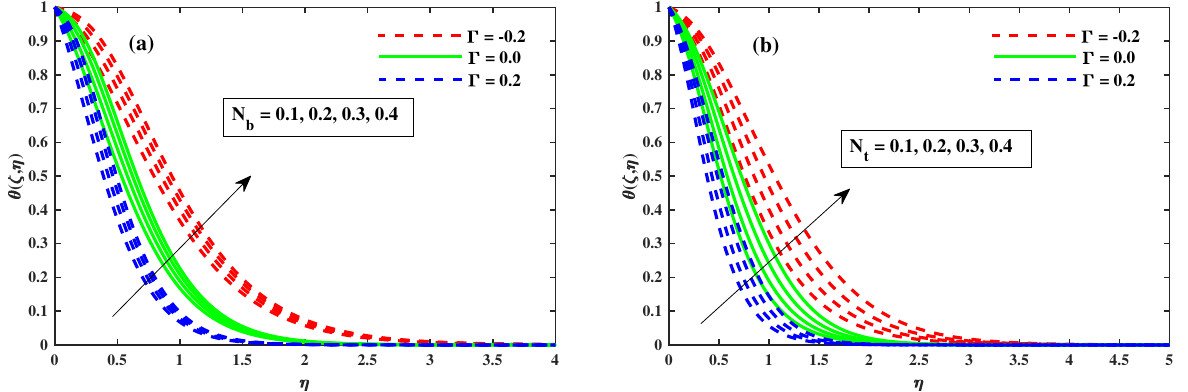
Figure 9. Influence of N b in ( a ) and N t in ( b ) on the temperature profiles.